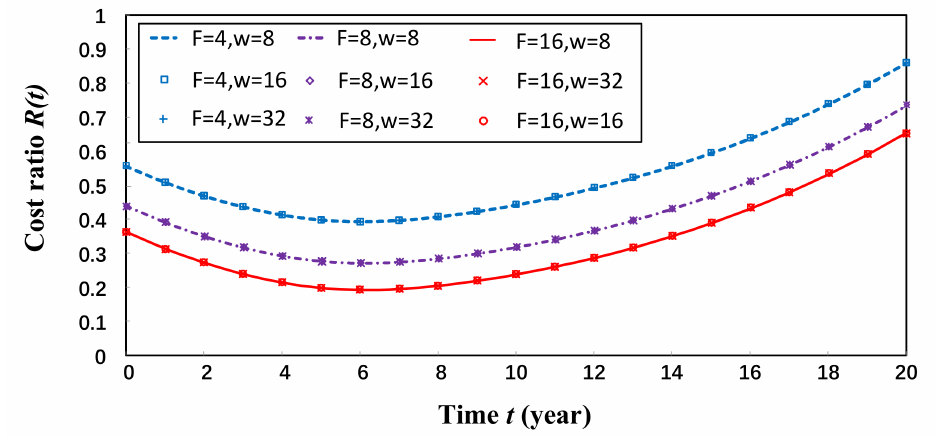
Figure 8. Cost ratio as a function of time in terms of years for different configurations in case of K = 30 and α =